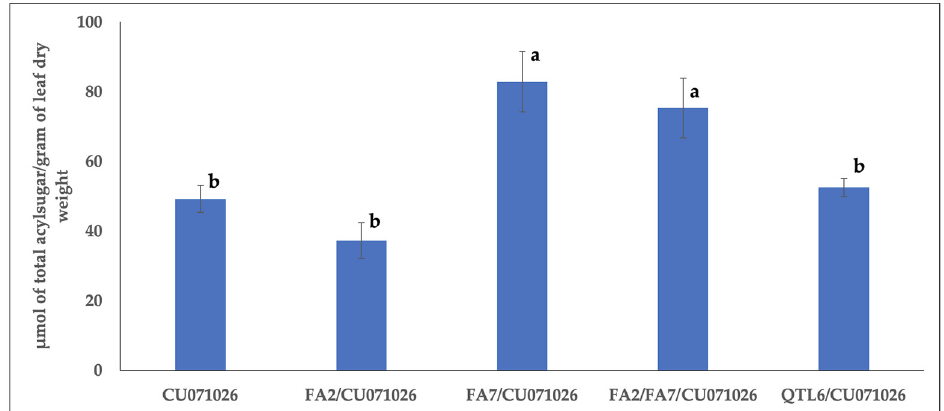
Figure 1. Bars represent averages of total acylsugars’ amount with standard errors in acylsugar- producing tomato lines in comparison with the benchmark breeding line CU071026. Bars with different letters indicate differences between treatment means using the Tukey–Kramer method following analysis of variance.